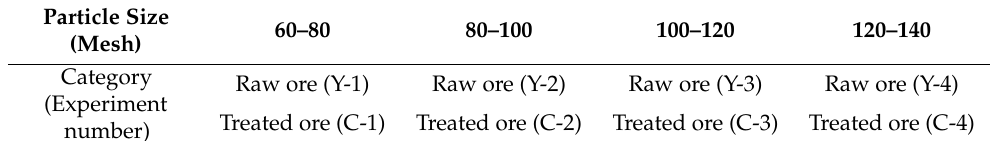
Table 4. Experimental design for the effect of the particle size of ore sample on desulfurization rate.